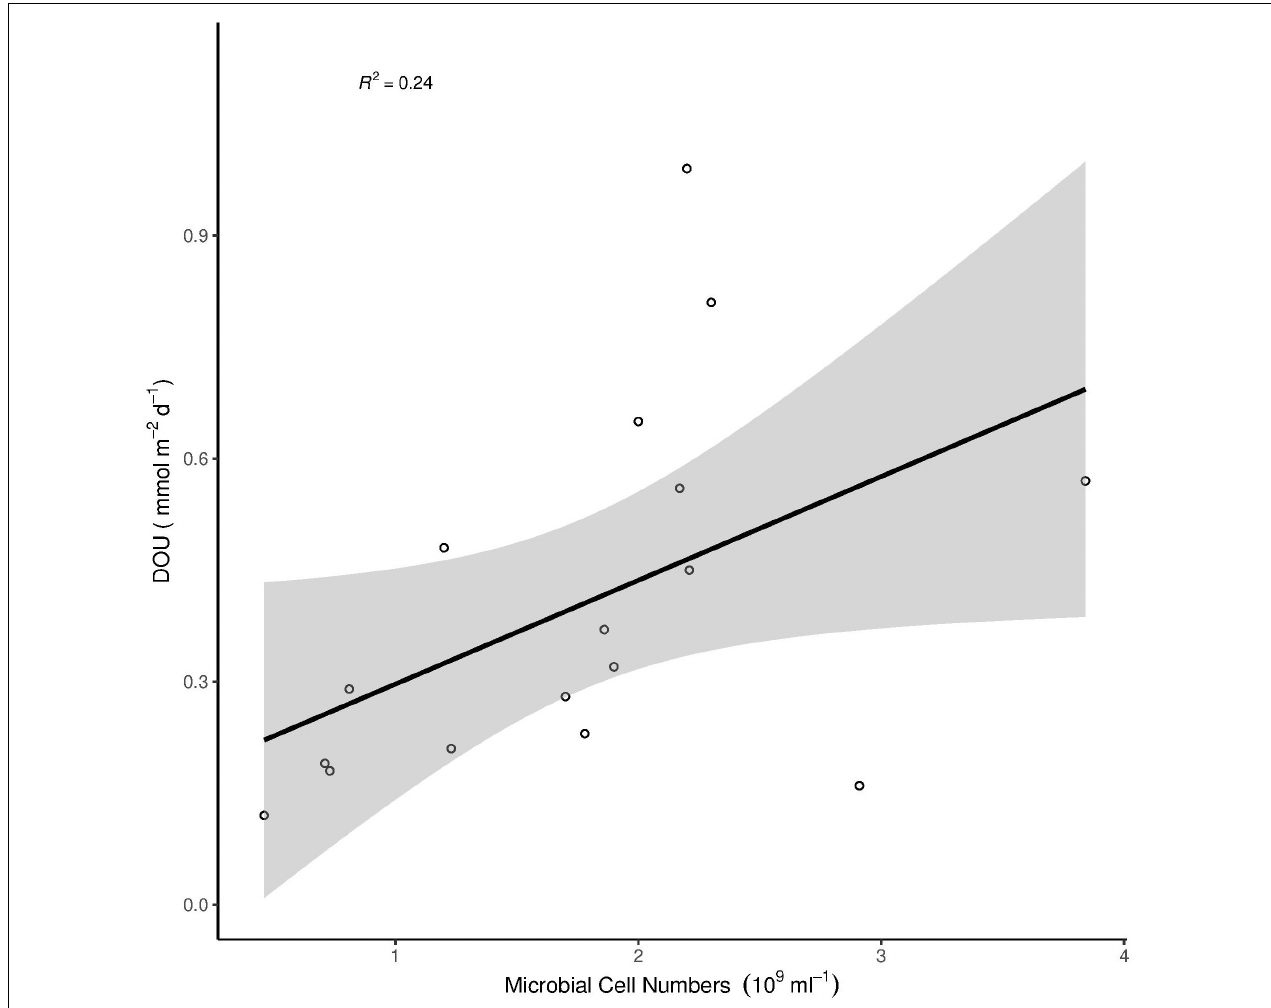
FIGURE 4 | Correlation of DOU with microbial cell numbers. The gray area around the linear model represents the 95% confidence interval. Multiple R 2 = 0.24, Adjusted R 2 = 0.19, p =